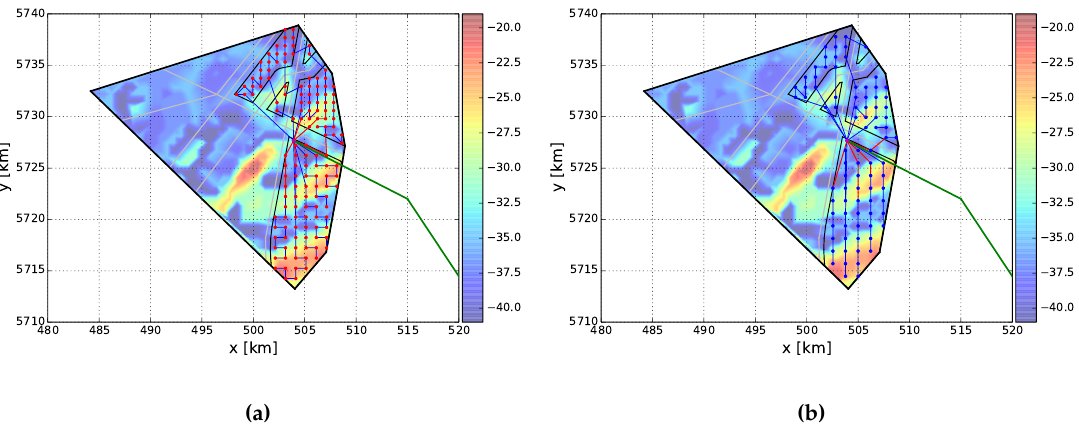
Figure 17. Layouts obtained with standard design philosophies and restricted to the design specifications [134]. Red and blue circles represent the 5 MW and 8 MW turbines, respectively. Gray lines are existing pipelines and telecom cables, blue and red lines are the collection system cables and green lines are the exporting HVac cables. The purple circles represent the offshore substations. ( a ) Layout with 140 turbines (5 MW); ( b ) Layout with 88 turbines (8